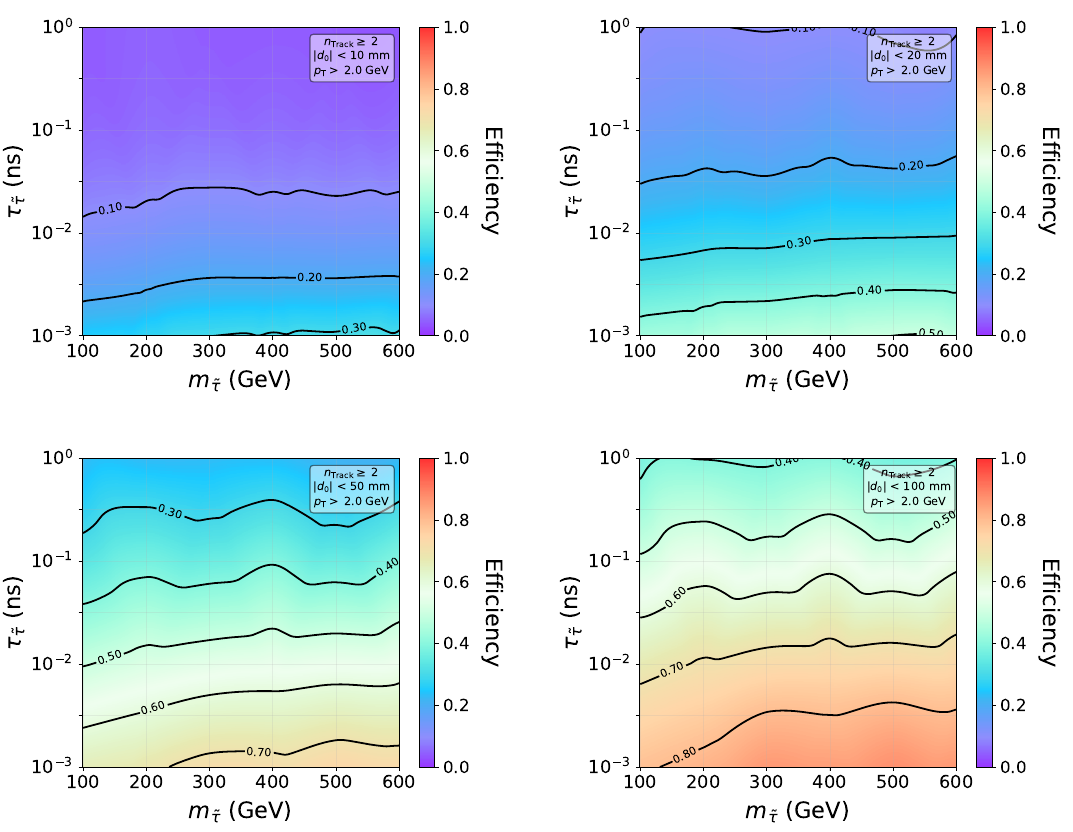
Figure 15. Event-level efficiencies for the stau model for a variety of track | d 0 | endpoints: 10 mm (top left), 20 mm (top right), 50 mm (bottom left), 100 mm (bottom right). In all cases, a linearly parameterized | d | efficiency is used. Tracks are required to have p 0 to have n 2 Track ≥